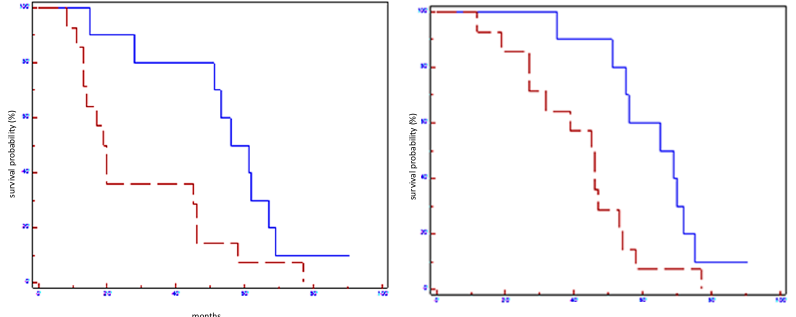
Figure 4. Prognostic impact of miR199a ‐ 3p on EFS (on the left) and on OS (on the right) in all population: blue line refers to patients with overexpression of miR199a ‐ 3p; red line refers to patients without overexpression of miR199a ‐ 3p.